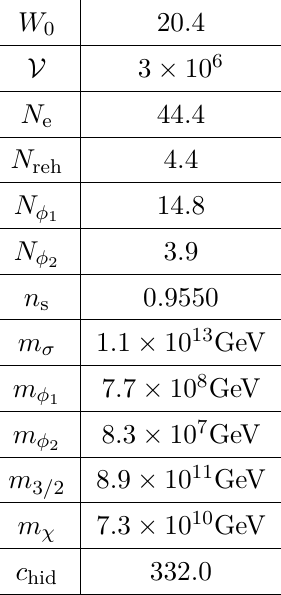
Table 2 . Microscopic parameters W 0 and V , the resulting e-folding numbers, n s , mass scales, and inflaton coupling to hidden degrees of freedom c at a benchmark point that gives the right hid amplitude of the density perturbations and the correct DM abundance. The input parameters are = Y = 0 . 01 , λ = 10 3 , N hid = 12 , and γ = 1 g s = 0 . 1 , Y φ φ 2 g 1